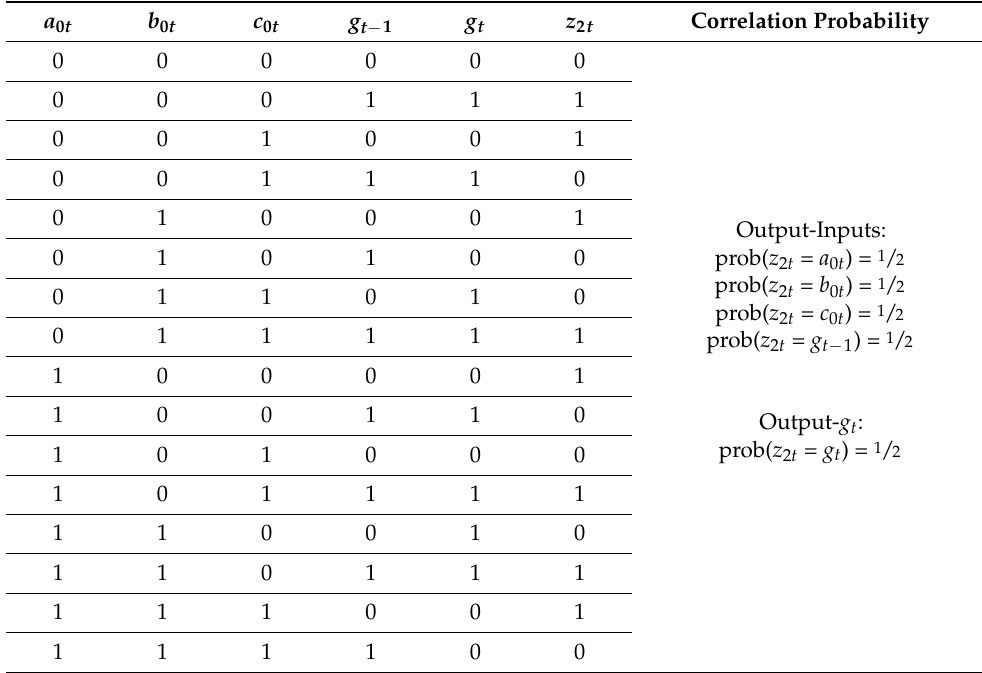
Table 8. Correlation probability of OSG 2 .